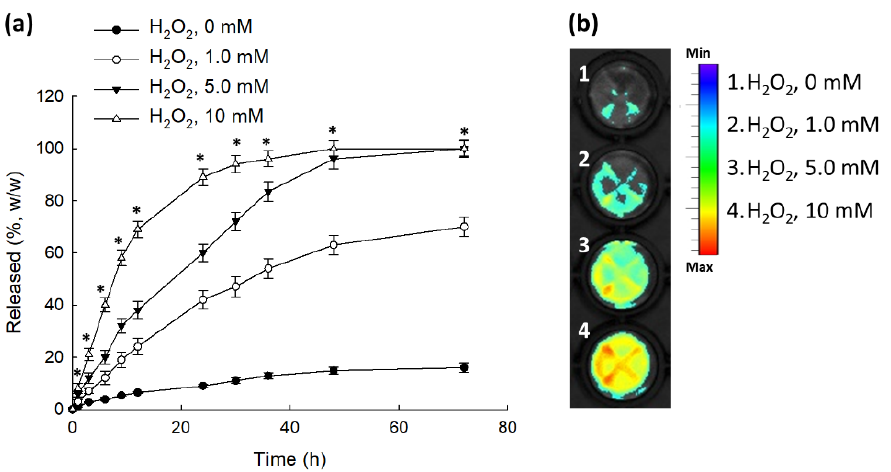
Figure 4. The effect of H 2 O 2 addition on the aqueous nanophotosensitizer solution. ( a ) Ce6 release from nanophotosensitizers. ( b ) Changes to fluorescence spectra of nanophotosensitizers in aqueous solution. For measurement of fluorescence intensity, the concentration of the nanophotosensitizer solution was adjusted to 1.0 mg/mL in PBS. H 2 O 2 was added to release media for the Ce6 release study. For fluorescence imaging, the nanophotosensitizer solution was incubated for 2 h at 37 °C in the absence or presence of different concentration of H 2 O 2 . Ce6 concentration in the release media was calculated from the calibration curve of Ce6 (Figure S1). * indicates statistical significance when H 2 O 2 (10 mM) was compared to the H 2 O 2 (0 mM) (ANOVA followed by Tukey’s test, p < 0.05).